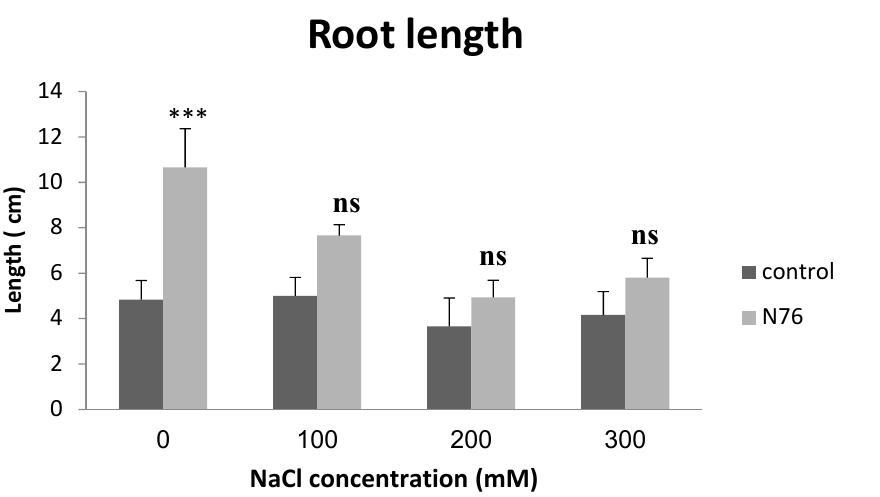
Figure 6. Effect of P. azotoformans on the root length of wheat seedlings under different NaCl concentrations. ns: no significant difference; ***: significant difference ( p < 0.001).